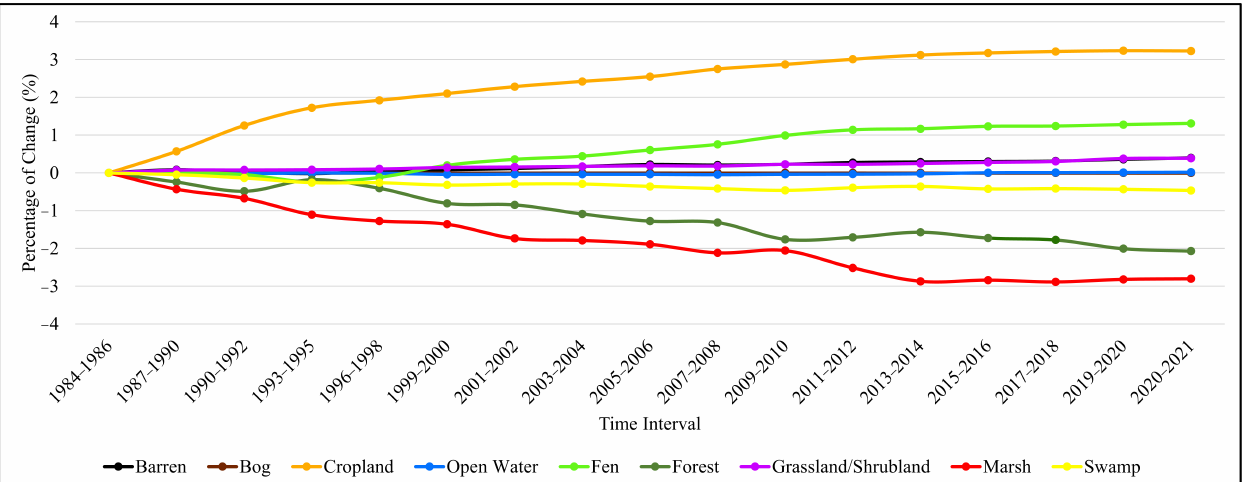
Figure 12. Trends of the relative area change for various classes in the Great Lakes basin extracted from the corresponding wetland maps from 1984 and